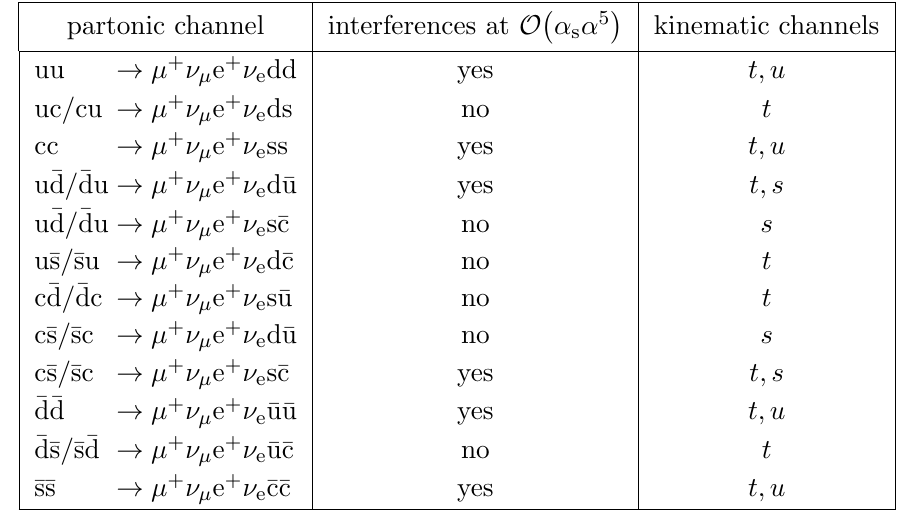
Table 1. Leading-order partonic channels contributing to the hadronic process pp The middle column indicates whether the channel gives rise to an interference contribution at